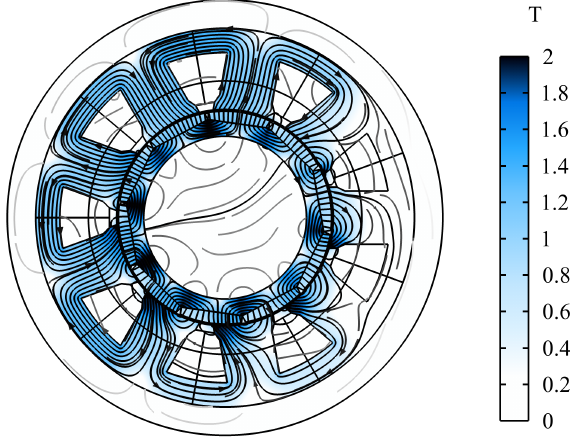
Figure 9. PMSM magnetic flux density distribution